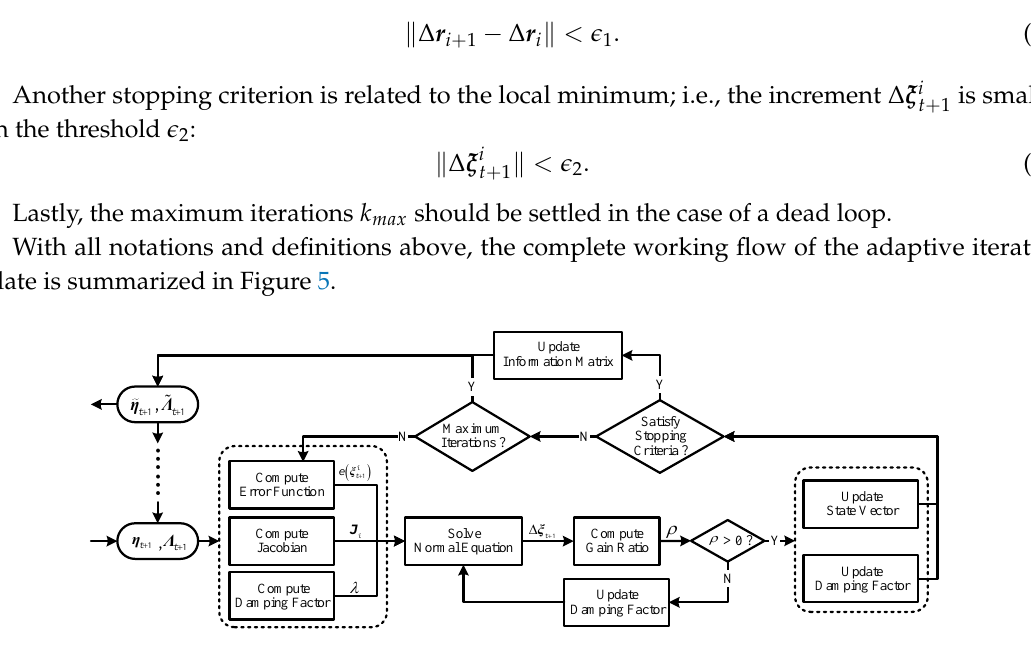
Figure 5. A schematic diagram of the adaptive iterative update with the damping factor.